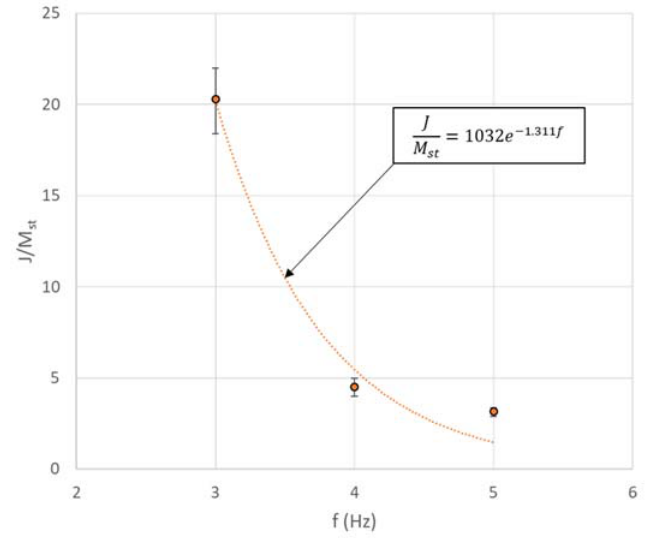
Figure 16. Variation of J / M st with excitation frequency from acceleration controlled tests. Figure 16. Variation of (cid:1836)/(cid:1839) (cid:3046)(cid:3047) with excitation frequency from acceleration controlled tests. Figure 16. Variation of (cid:1836)/(cid:1839) (cid:3046)(cid:3047) with excitation frequency from acceleration controlled tests.